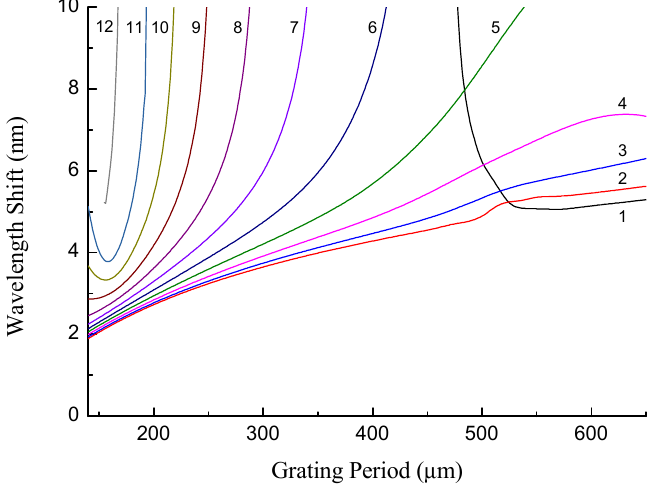
Figure 10. Absolute value of the wavelength shift for LP 1 j modes as a function of grating period for the temperature change from 300 K to 0 K.